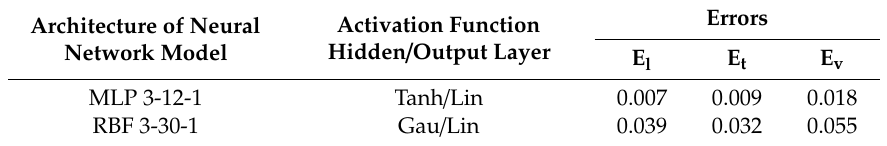
Table 3. The basic information on the structure and training (learning) (El), test (Et), and validation (Ev) error values of MLP and RBF neural networks adopted as models of mold contamination in rapeseed ecosystems with water activity aw = 0.75–0.90 stored at 12–30 ◦